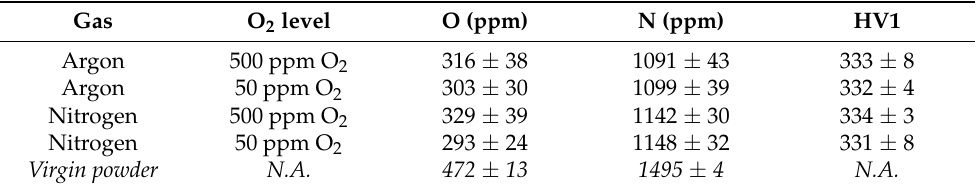
Table 1. Oxygen and nitrogen contents in the cubes built using argon and nitrogen atmospheres at different residual oxygen contents and the virgin Alloy 718 powder. The hardness (HV1) measured on the as-built cubes is also displayed. Gas O 2 level O (ppm) N (ppm) HV1 Argon 500 ppm O 2 316 ± 38 1091 ± 43 333 ± 8 Argon 50 ppm O 2 303 ± 30 1099 ± 39 332 ± 4 Nitrogen 500 ppm O 2 329 ± 39 1142 ± 30 334 ± 3 Nitrogen 50 ppm O 2 293 ± 24 1148 ± 32 331 ± 8 Virgin powder N.A. 472 ± 13 1495 ± 4